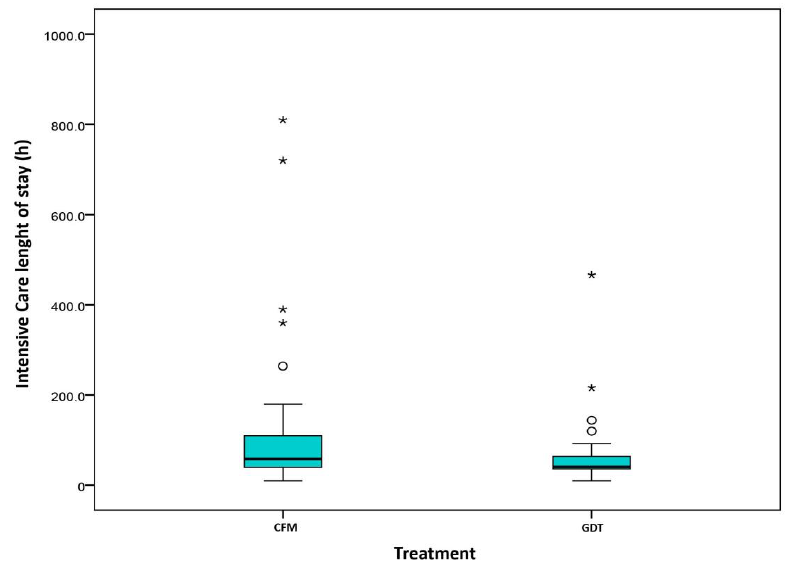
Figure 4. Intensive care length of stay (hours). Classical fluid management (CMF)/Goal directed therapy (GDT).